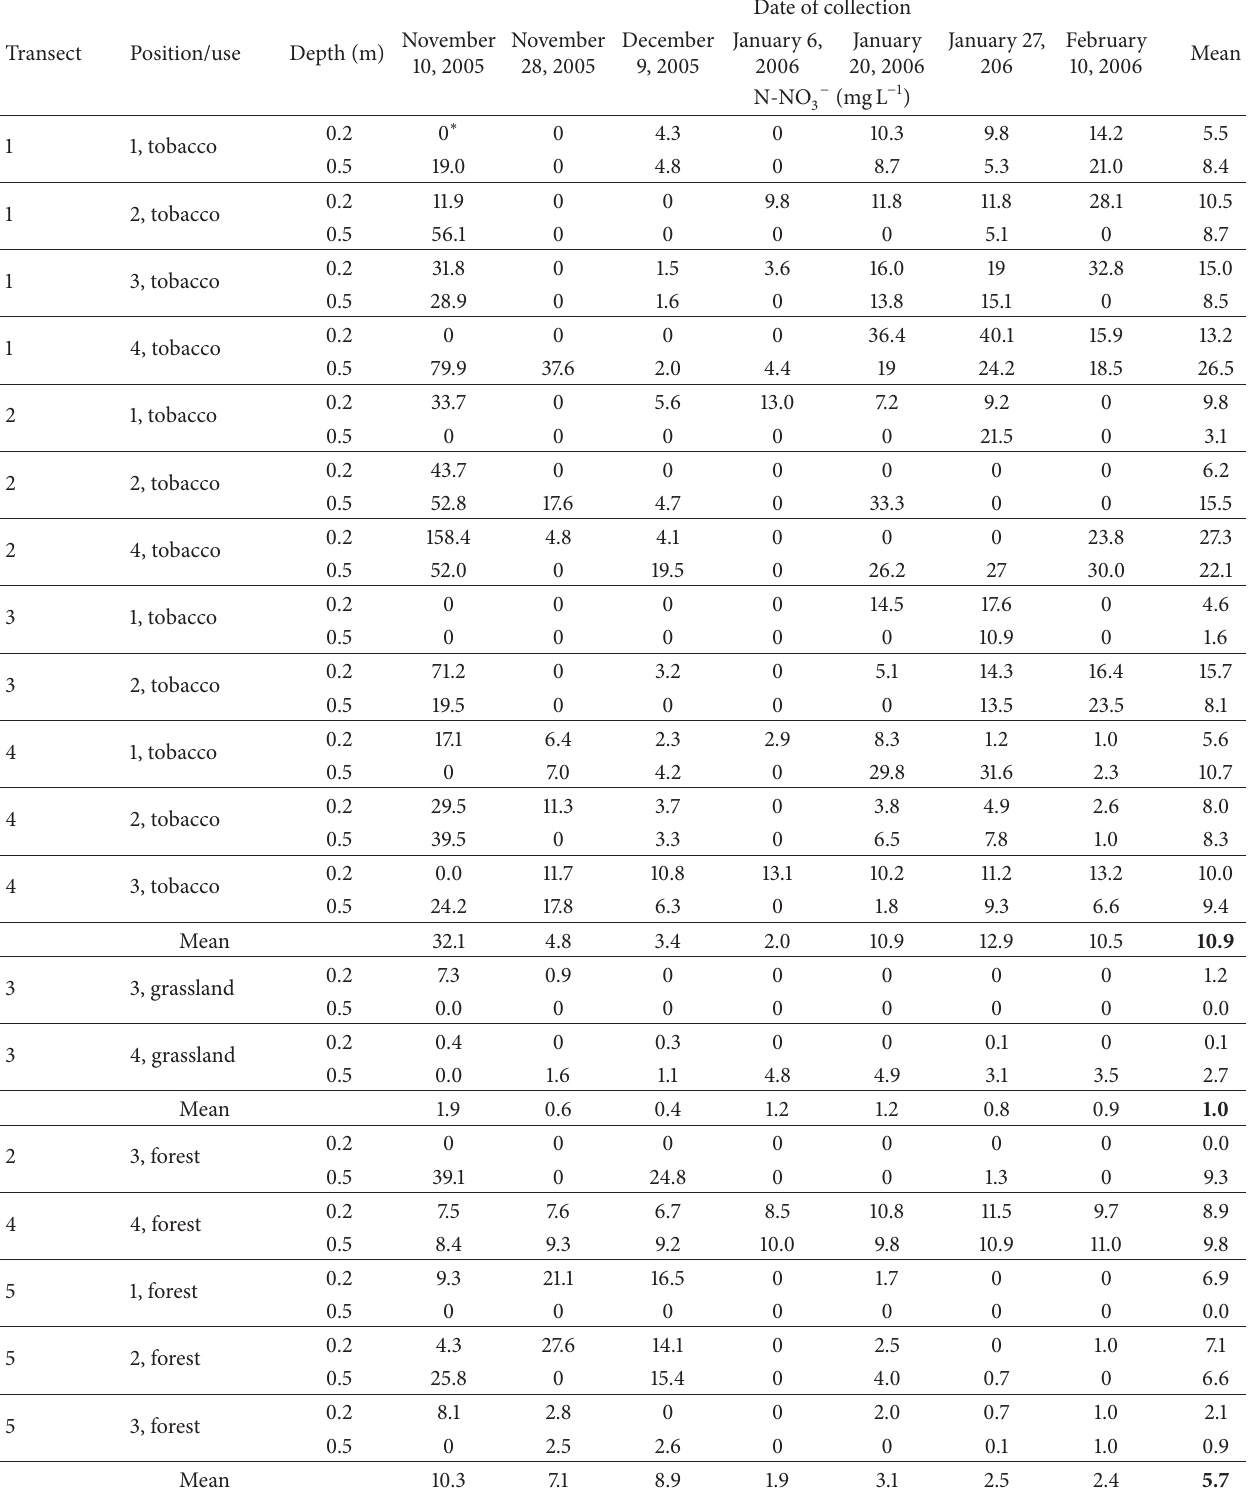
Table 3: Nitrate concentration in soil solution under different conditions of land uses and landscape positions in the watershed.